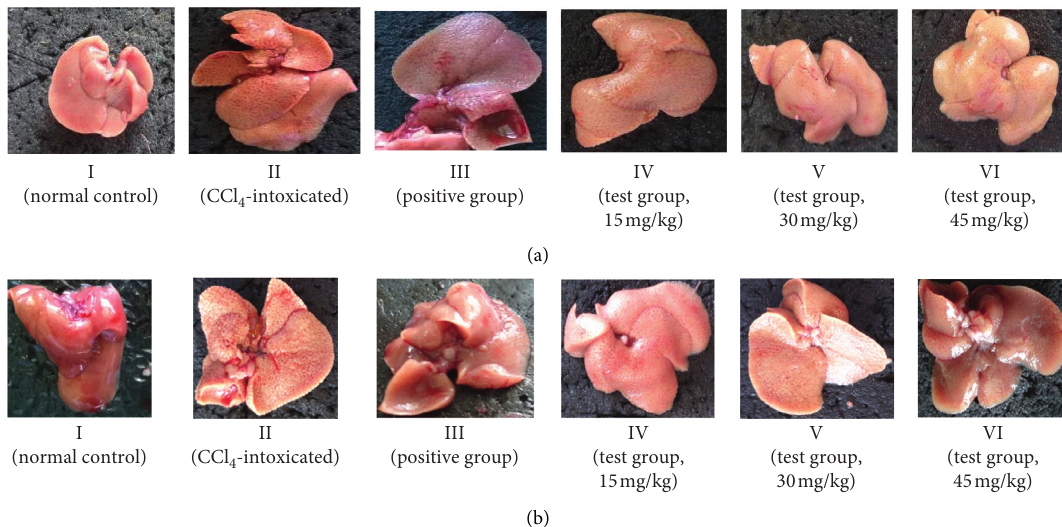
Figure 1: Photographs of livers from normal and treated mice. (a) The methanol extract of the stems of C. viscosa (CVSM). (b) The methanol extract of the stems of C. chelidonii (CCSM).